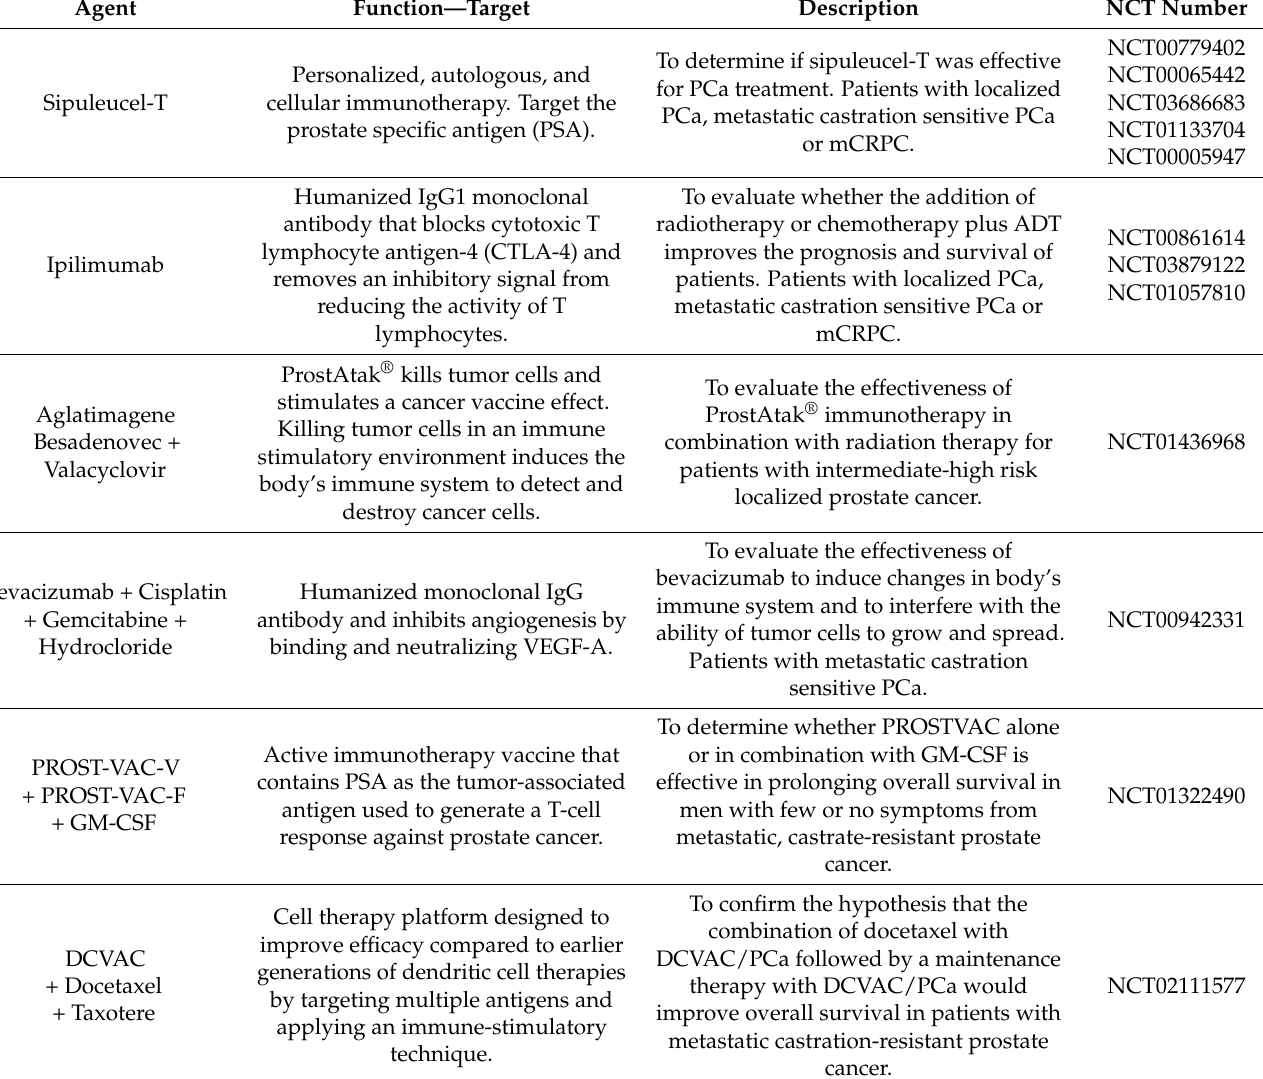
Table 2. Ongoing clinical trials (Phase III) in prostate